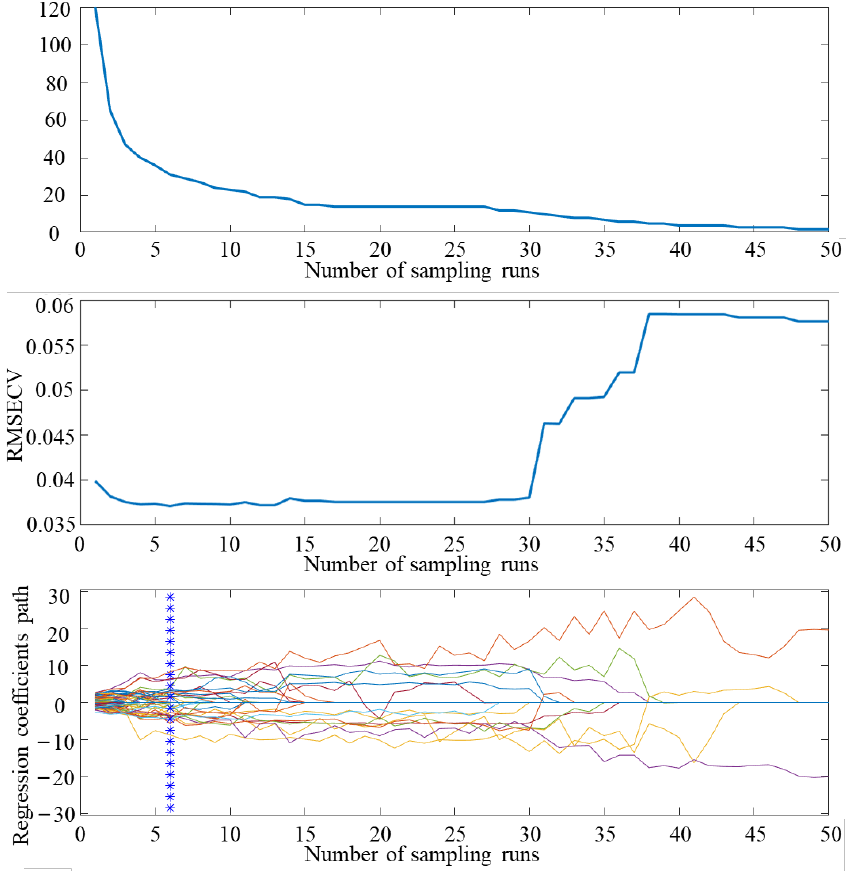
Figure 9. CARS feature screening